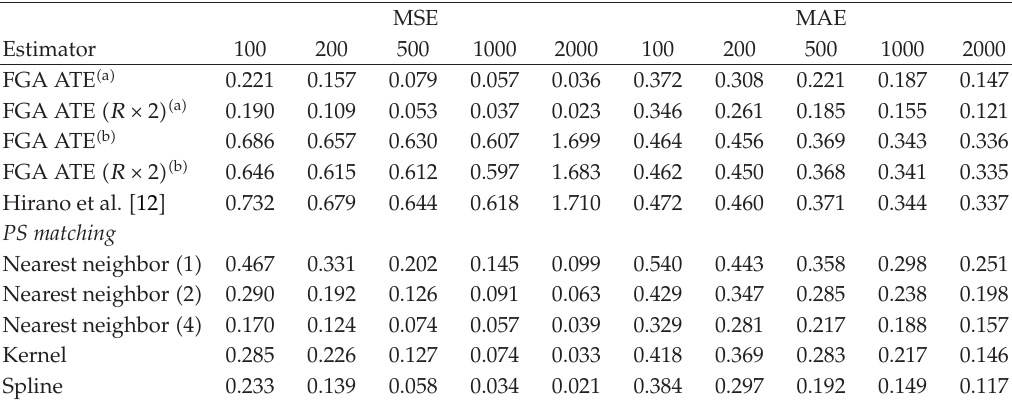
Table 1: ATE Monte Carlo